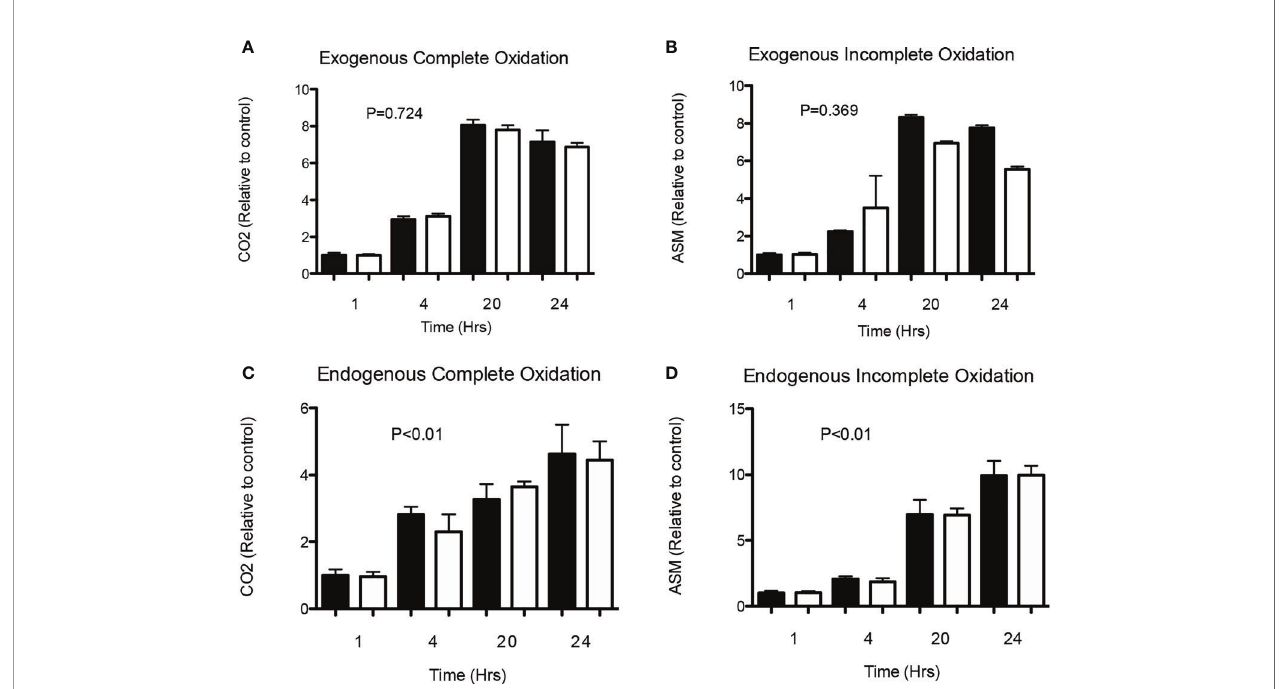
FIGURE 1 | Time-effect of SA on exogenous and endogenous fat oxidation in HSkMC. (A) Complete ( 14 CO 2 ) and (B) incomplete (ASM) 14 C-palmitate exogenous oxidation (2 independent experiments) was measured following 1, 4, 20 and 24 hours of incubation without (0 mmol/l) or with (0.1 mmol/l) SA. In addition, following 24h pre-incubation with 14 C-palmitate, (C) complete ( 14 CO 2 ) and (D) incomplete (ASM) 14 C-palmitate endogenous oxidation (2 independent experiments) was measured following 1, 4, 20- and 24-hours incubation without (0 mmol/l) or with (0.1 mmol/l) SA. Data expressed as mean and standard deviation and expressed as relative to control (black). P value corresponds to Kruskal-Wallis test. Post-hoc test showed no differences between control and acetate treated cells at each